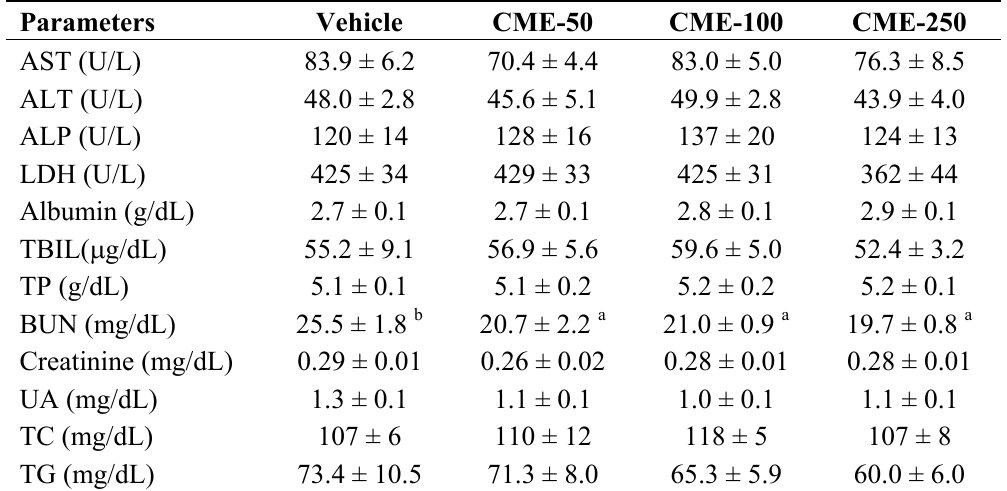
Table 2. Biochemical analysis of the CME treatment groups at the end of experiment.